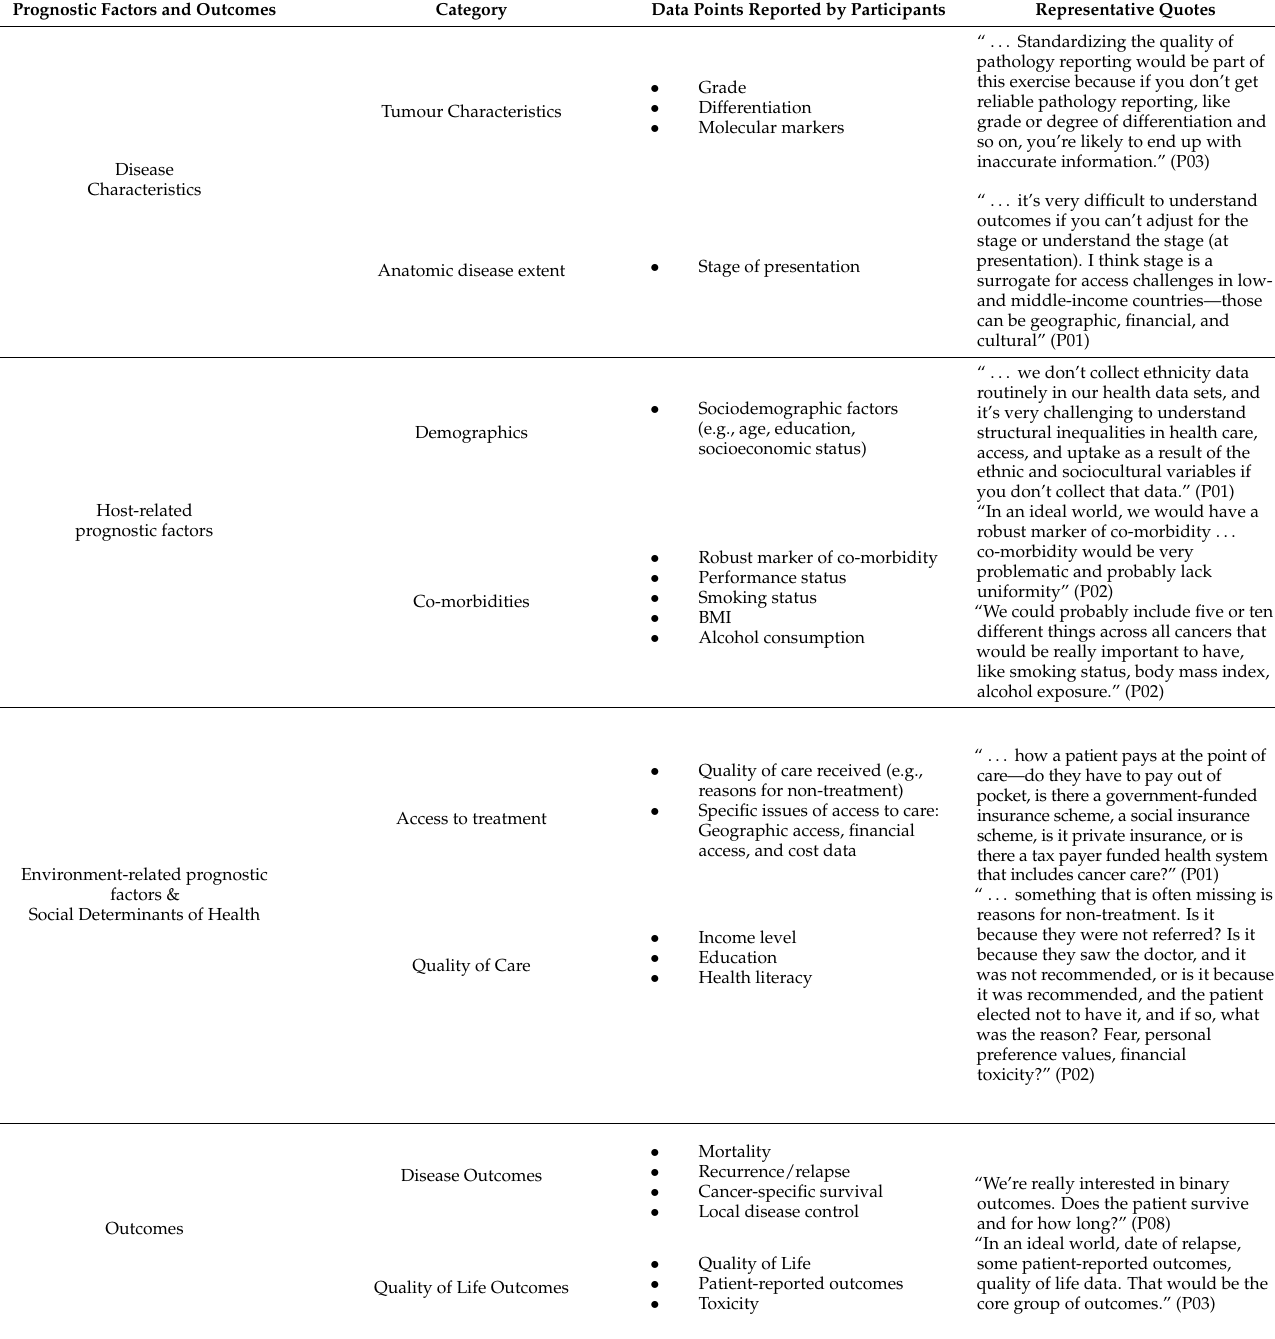
Table 1. Prognostic factors and clinical outcomes collected in an ideal